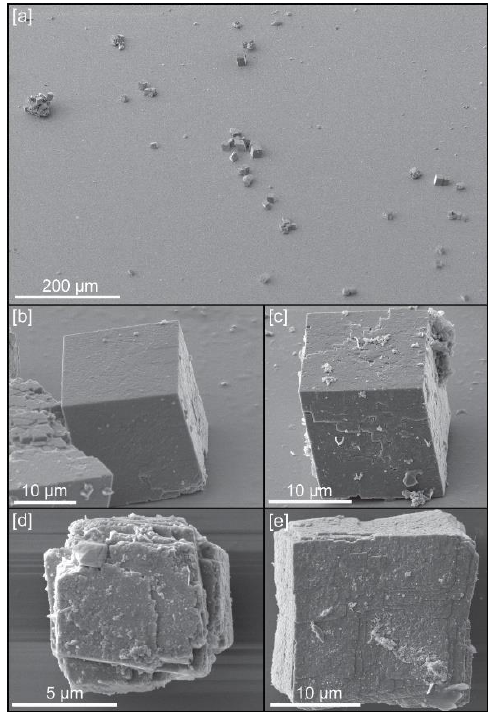
Figure 1. Calcite crystals used in this study: ( a ) General view of crystals deposited on the surface of a silicon wafer; ( b ) Example of crystal grown with chitin hydrogel ( c ) Example of crystal grown with chitin at 0.12 mg / mL concentration of yatalase; ( d ) Example of crystal grown with chitin at 1.2 mg / mL concentration of yatalase; ( e ) Example of crystal grown with chitin nanofibers.